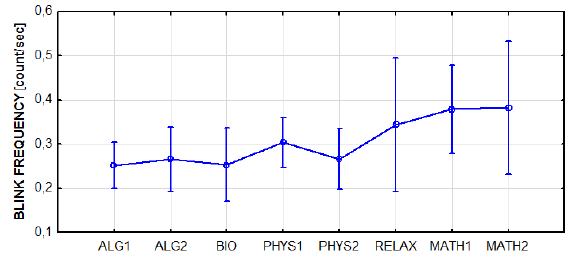
Figure 4. The blink frequency - a distribution of the mean values for the particular tasks and the relax time.